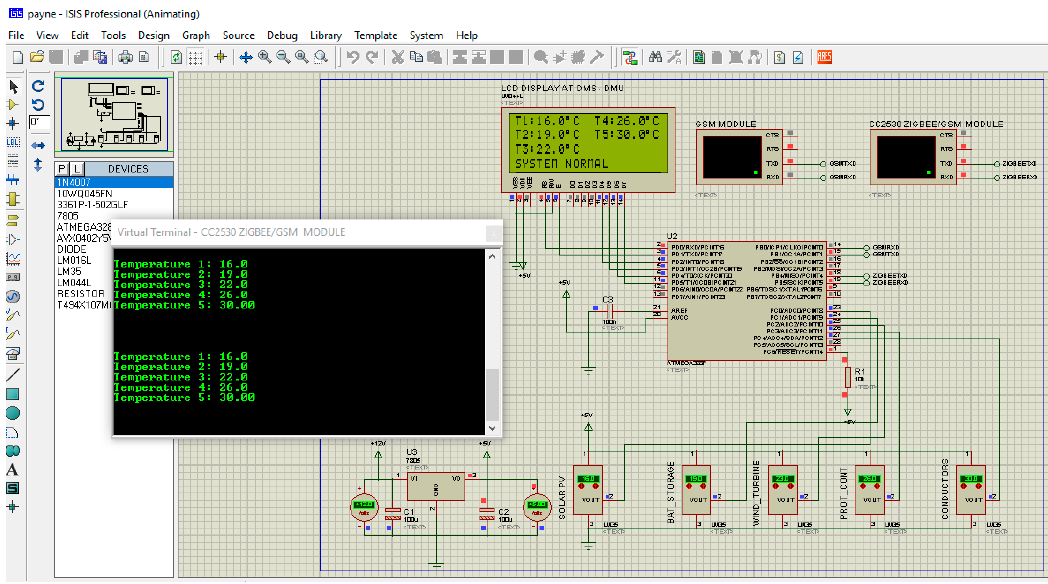
Figure 9. System normal operation temperatures 15 °C to 30 °C.